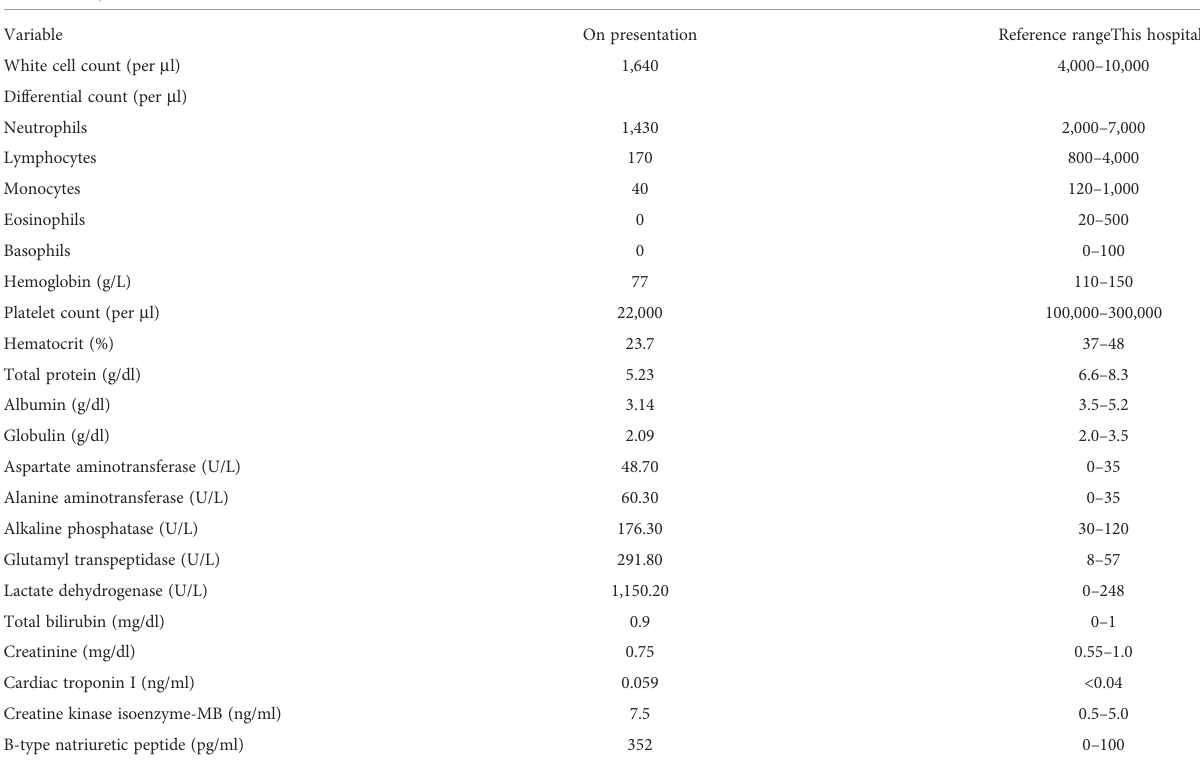
TABLE 2 Patient characteristics on